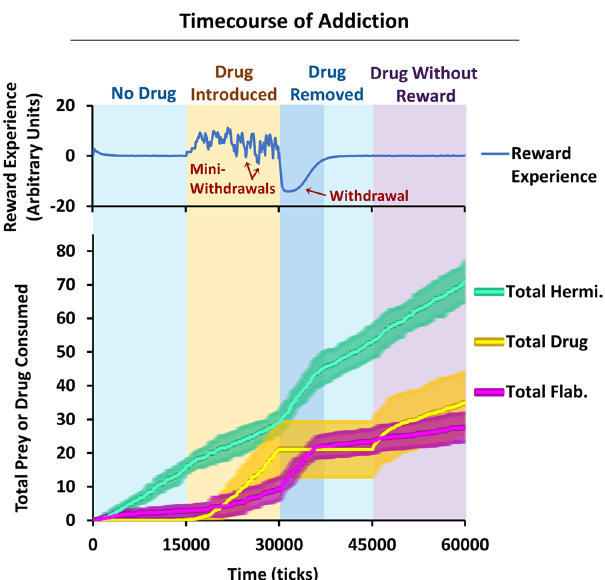
Figure 4. Phases of addiction. In Addiction Cycle Mode, Drug is introduced and removed. In these phases, the forager experiences desensitization, withdrawal and cravings. The curves displayed are timecourses of reward experience and the total numbers of different prey or Drug consumed, averaged over 10 trials of the Addiction Cycle Mode simulation. Error bars (SEM) are shown for total Hermi, Drug, and Flab consumed. When Drug is introduced, first-time Drug consumption typically occurs by accident or at low satiation. As Drug consumption continues, the forager experiences mini-withdrawals, wherein reward experience swings rapidly between positive and negative values. When Drug is removed, the forager undergoes withdrawal, during which loss of reward exacerbates the effects of hunger, increasing non-selective consumption of prey. In the Drug Without Reward phase, when Drug is first reintroduced with the same odor signature but no reward, the forager quickly resumes Drug consumption, even after recovery from withdrawal, since the associative strength for the Drug (“cravings”) is still high. In later stages of Drug Without Reward phase, Drug consumption is significantly reduced due to the decrease in Drug’s associative